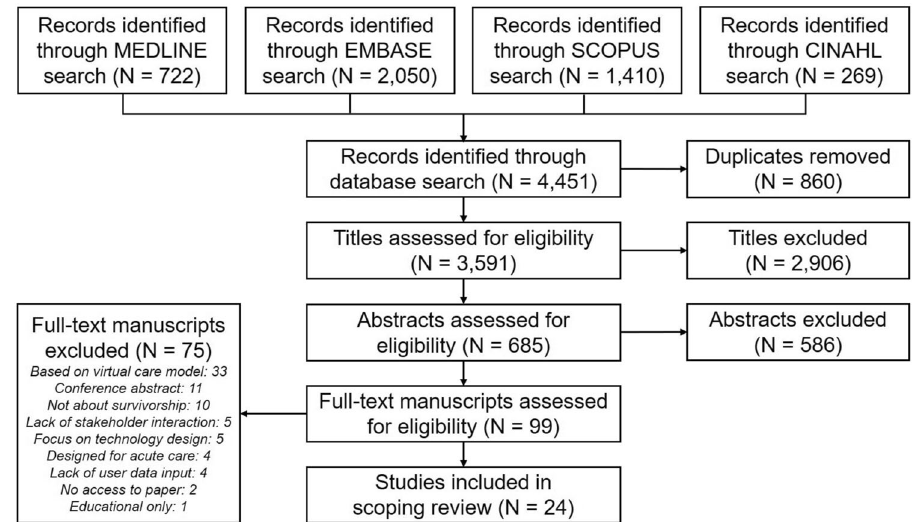
Fig. 1 Flow diagram summarizing study